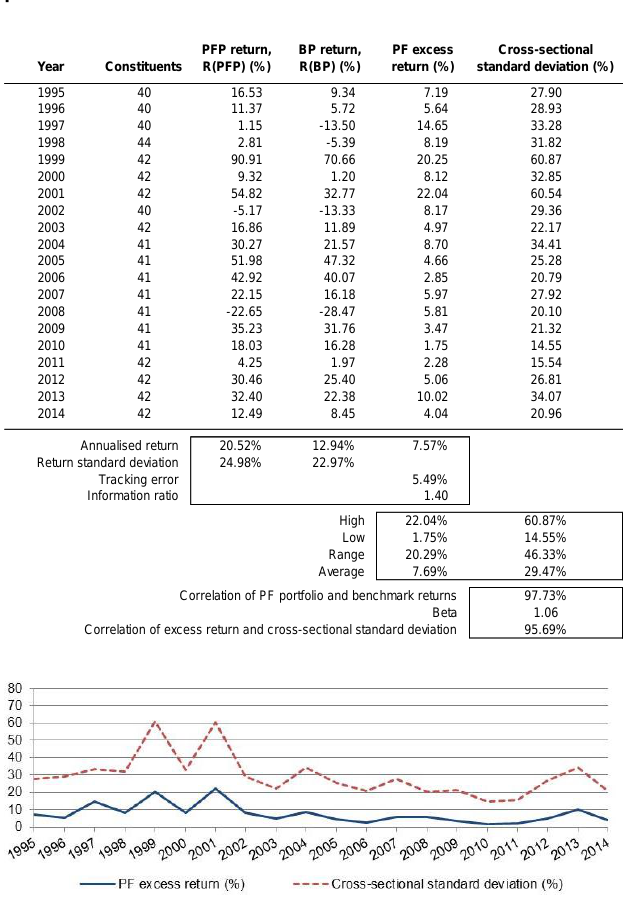
Table 3: Large Cap segment benchmark and PF portfolio results